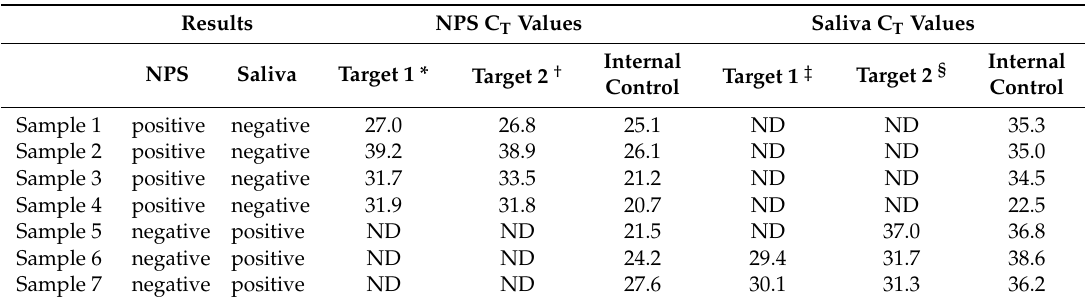
Table 2. Discordant results of matched nasopharyngeal swab (NPS) and saliva sample